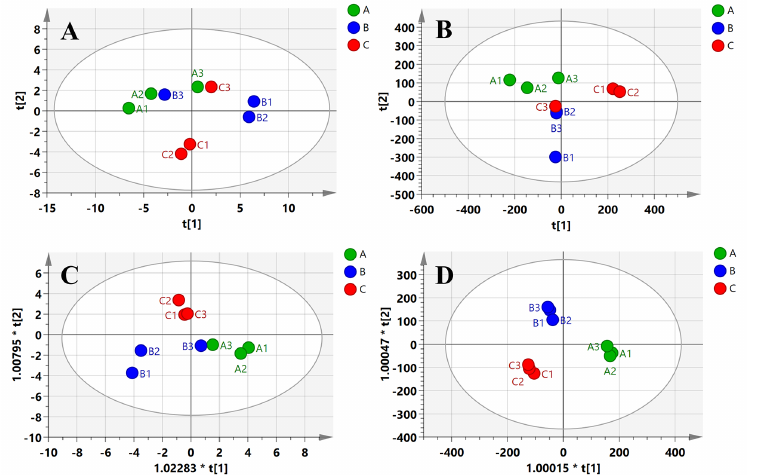
Figure 6. Scores plot for principal component analysis (PCA) and orthogonal partial least square dis- criminant analysis (OPLS–DA) models of compounds obtained from A. tsao-ko oils of different regions. ( A , B ) PCA models by GC–MS and GC–IMS; ( C , D ) OPLS–DA models by GC–MS and